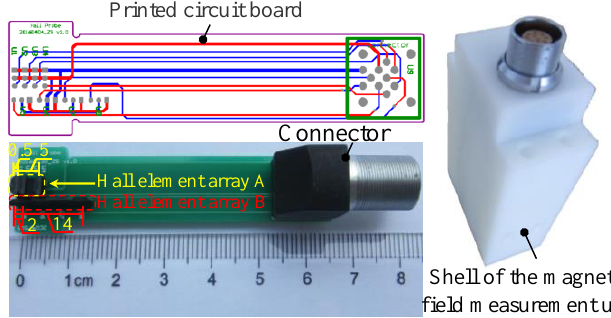
Figure 7. The magnetic field measurement unit for evaluating the stress in steel wires.